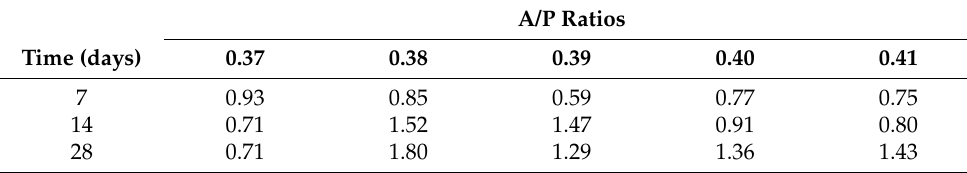
Figure 14. Compressive strength versus time. Table 4. Compressive strength standard